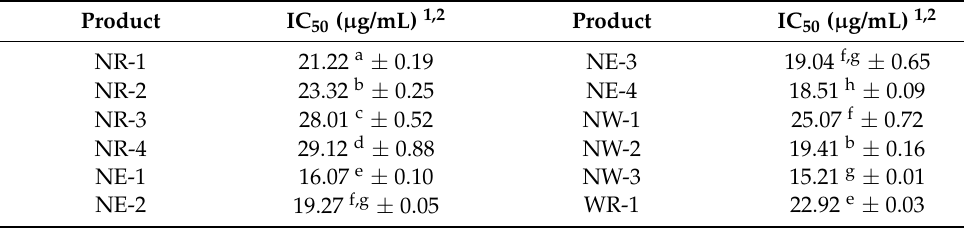
Table 5. DPPH antioxidant activity of extracts from C. longa